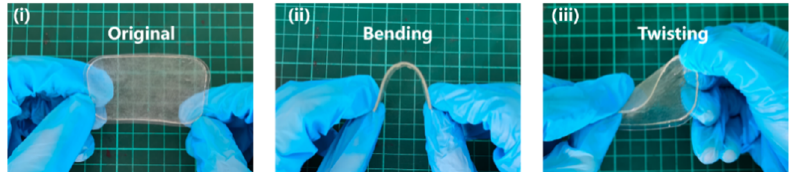
Figure A1. Flexibility diagram of hydrogels electrodes. ( i ) original state of hydrogel ( ii ) bending state of hydrogel ( iii )twisting state of hydrogel.